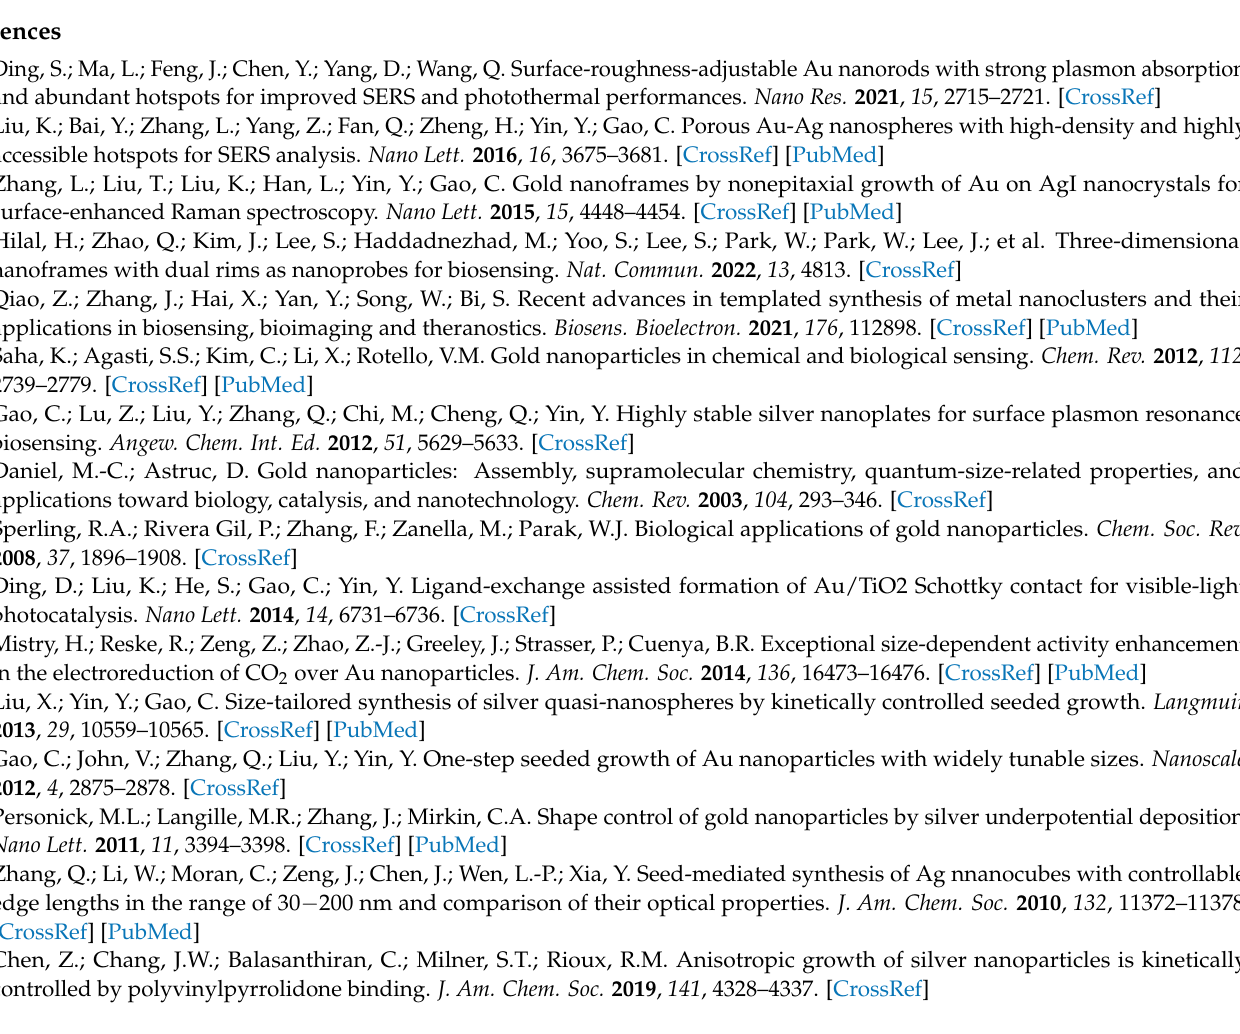
for 10 h. Figure S13: TEM image of the Au nanoplates after treatment in Fe(NO 3 ) 3 (2 mM) for 10 h. Figure S14: SERS of a crystal-violet solution (concentration, 10 − 5 M) without Au nanoplates (signal acquisition time, 30